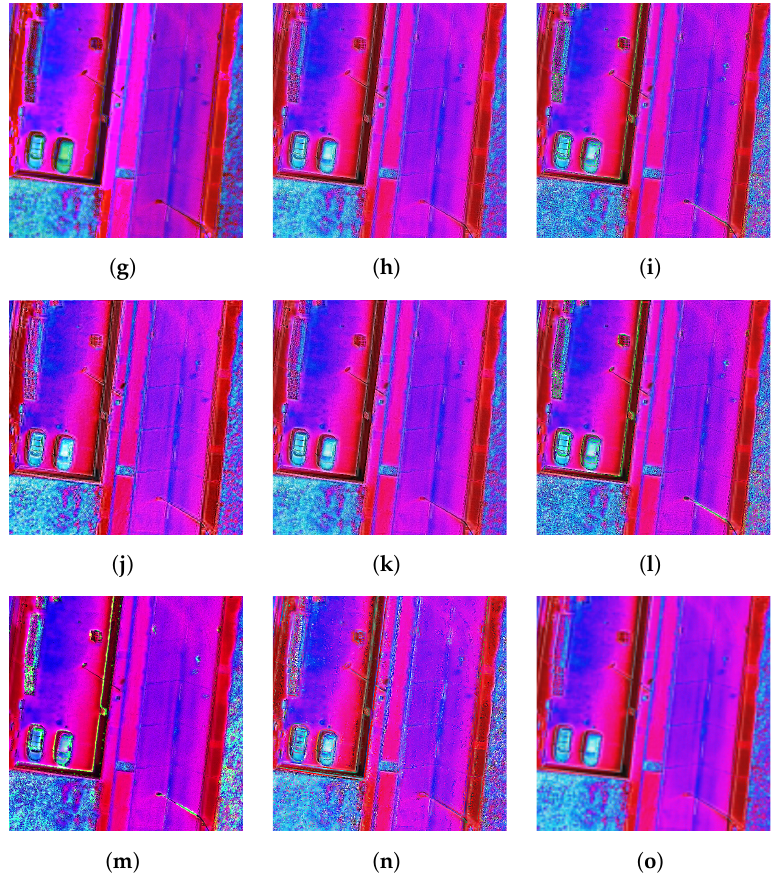
Figure A1. UAV Illescas dataset RGB: ( a ) Reference image; ( b ) Low-resolution upsampled image; ( c ) PCA; ( d ) IHS; ( e ) BDSD; ( f ) GS; ( g ) PRACS; ( h ) HPF; ( i ) SFIM; ( j ) INDUSION; ( k ) MTF-GLP;